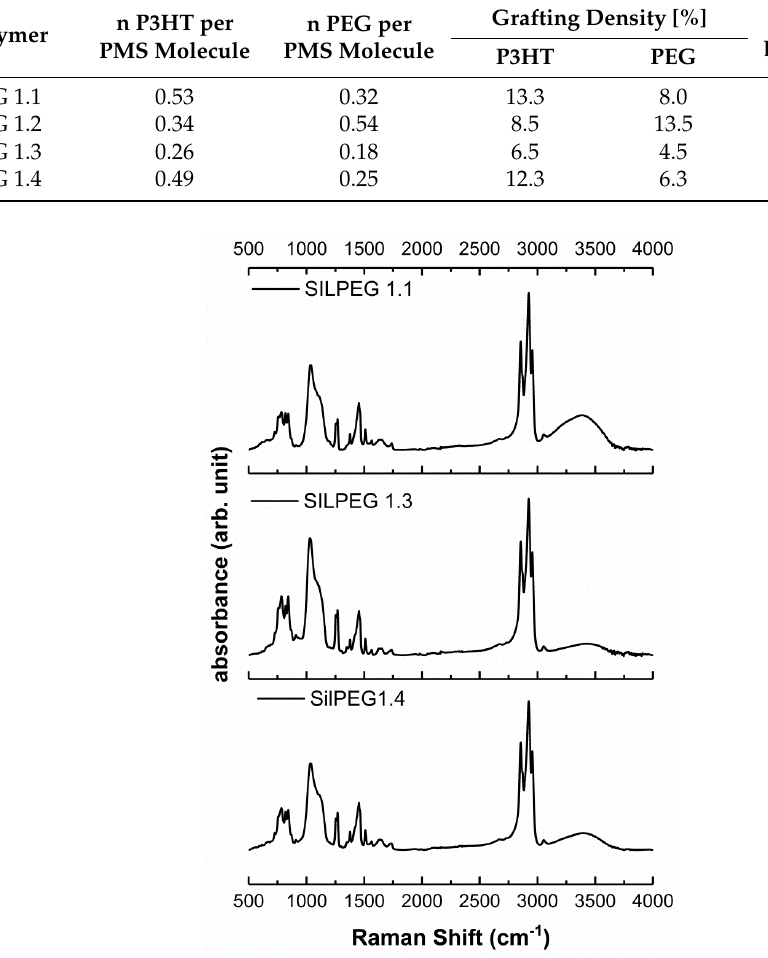
Figure A5. 1 H-NMR spectrum of poly(methylhydrosiloxane)-graft-[poly(ethylene glycol) methyl ether methacrylate] (PEG M n ≈ 500) (SilPEG0). Table A1. Grafting density of P3HT and PEG in SilPEG copolymers; calculations based on 1 H-NMR analyses.